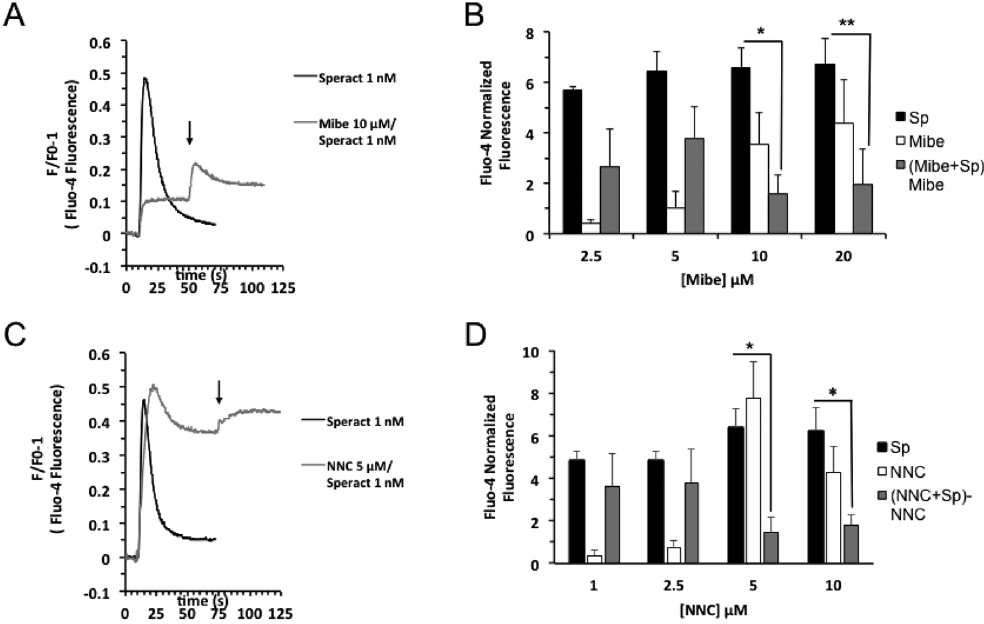
Figure 8. Catsper participates in the speract signaling cascade. Fluo-4 labelled S. purpuratus sea urchin sperm diluted (1:10) in 1CaSW pH 7.0, were further diluted (5 μ l) in 800 μ l ASW pH 7.8. After recording the fluorescence for 10 seconds, 1 nM speract ( A and C ), 10 μ M Mibefradil (Mibe) ( A ), or 5 μ M NNC- 055-396 (NNC) ( C ), were added. Channel blockers were incubated for 1 min. In ( A and C ) arrows indicate speract additions. ( B and D ) Summary of experiments performed as in ( A ) or ( C ) respectively, assessing the fluorescence change in the maximum after additions. The Fluo-4 normalized fluorescence (%) was obtained considering the fluorescence obtained after adding 0.05% Triton-X100 as 100%. Bars represent the mean ± s.e.m. ( B ) n = 3–8. ( D ) n = 4–5. * p < 0.001 and ** p <